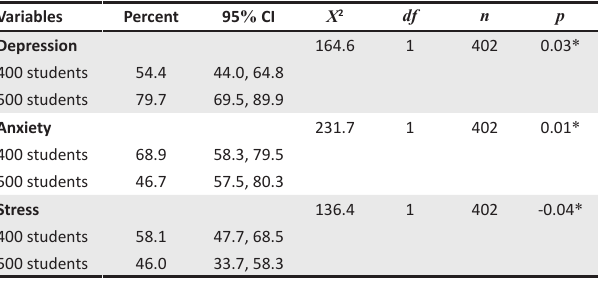
TABLE 4: Chi-square test of difference in psychological symptoms between level 400 and 500 students.